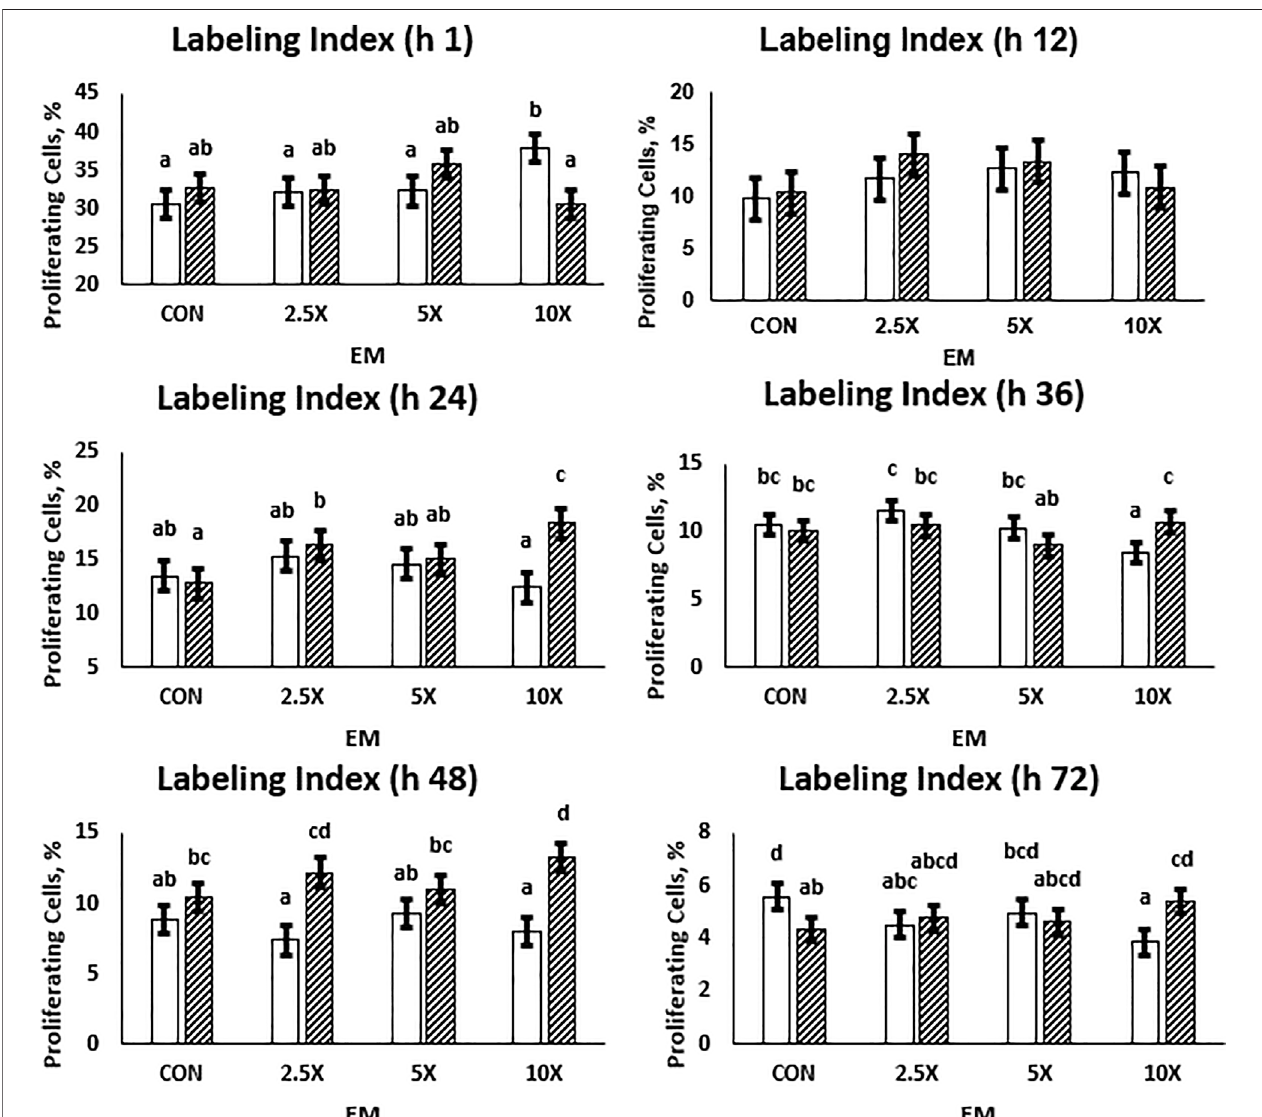
FIGURE 2 | The cell proliferation responses are dependent on the time of measurement and decrease as cells reach con fl uency. High glucose cells are generally greater than Low cells, and the labeling index in High cells across each treatment is representative of growth rates. Low glucose cells are represented by the solid white bar. High glucose cells are represented by the dashed bar. Means without a common superscript differ in glucose × epigenetic modi fi ers ( p ≤ 0.05). Three replicates per treatment per timepoint were measured. Error bars represent the average standard error of the mean within a glucose